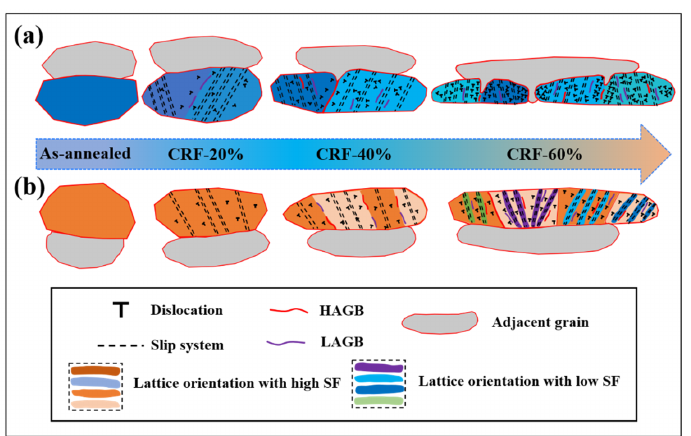
Figure 13. Schematic diagram of the grain re fi nement mechanism of 5A06 aluminum alloy sheets during the CRF process: ( a ) grains with a low SF and ( b ) grains with a high SF.